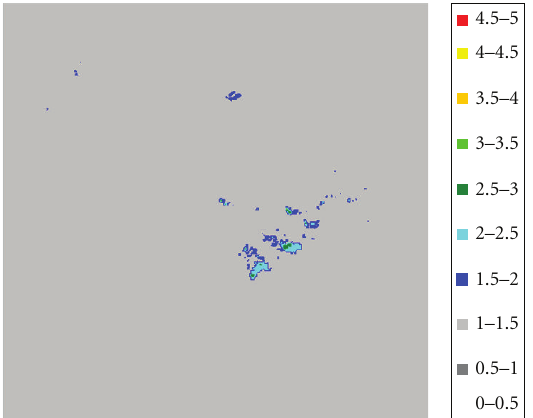
Figure 6: Cost map generated by the Crusher during field testing for the region shown in Figure 4. Plotted is the log of the cost associated with each ( x , y ) position within the scene. The large light blue areas are the high-cost regions created by ground occlusion.